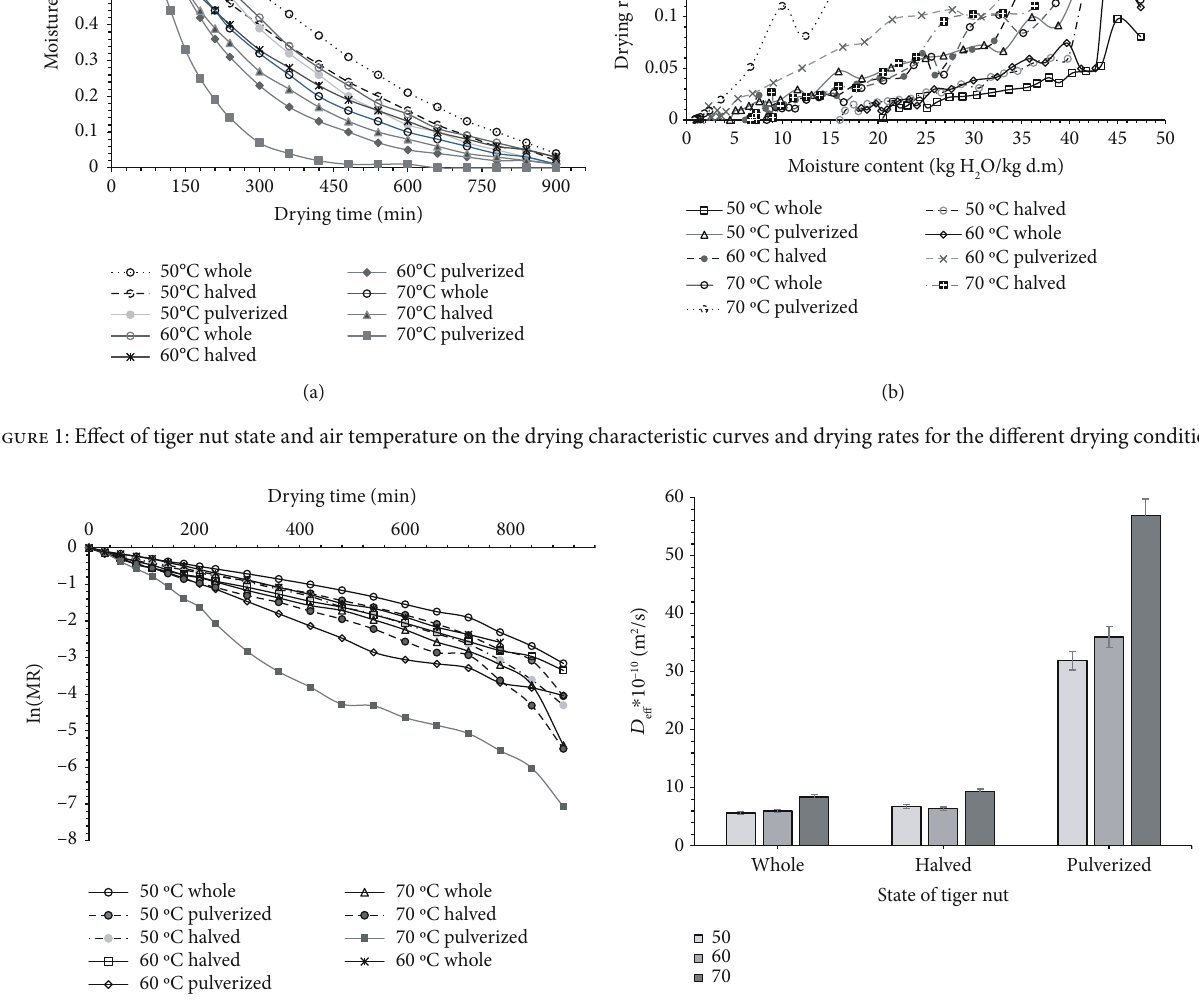
) for tiger nuts dried at the various eff